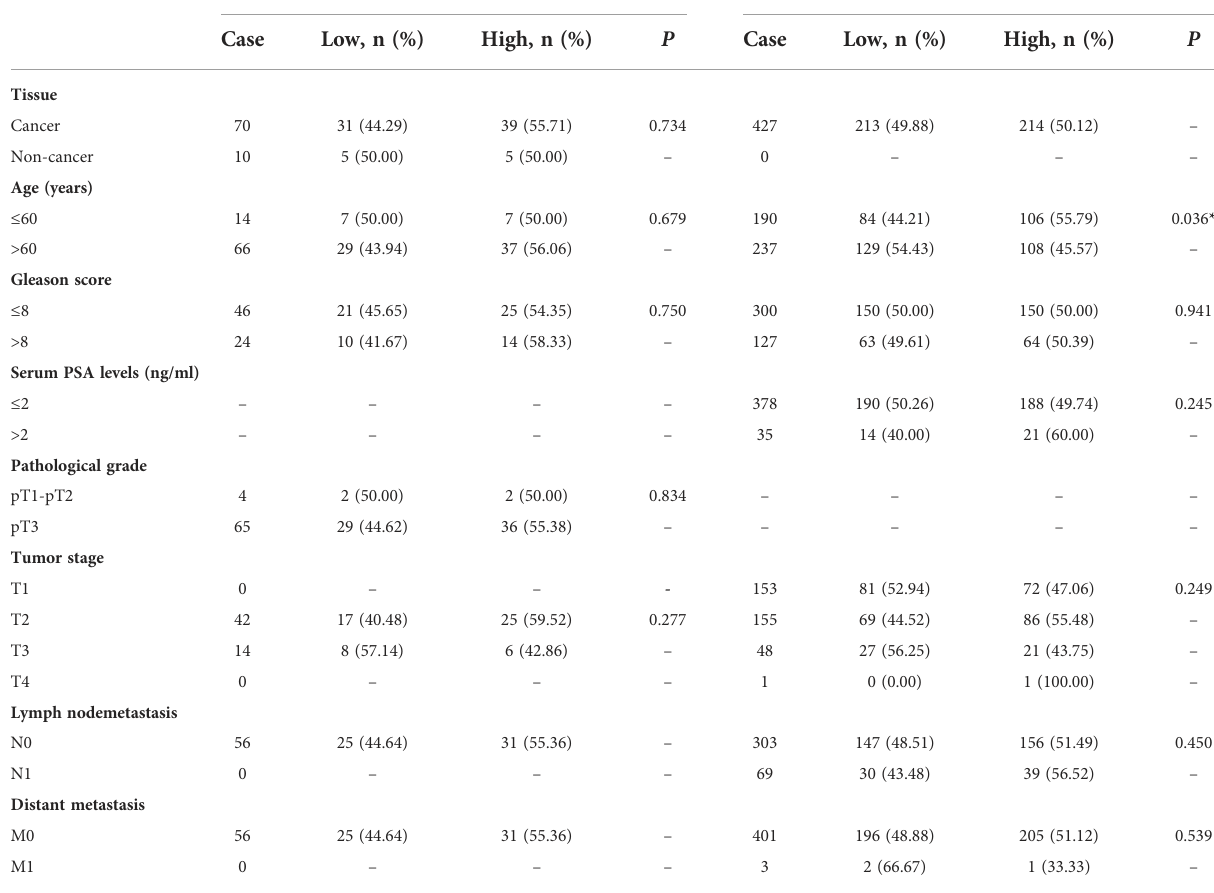
TABLE 4 Correlation of CCR7 expression with clinicopathological features in PCa